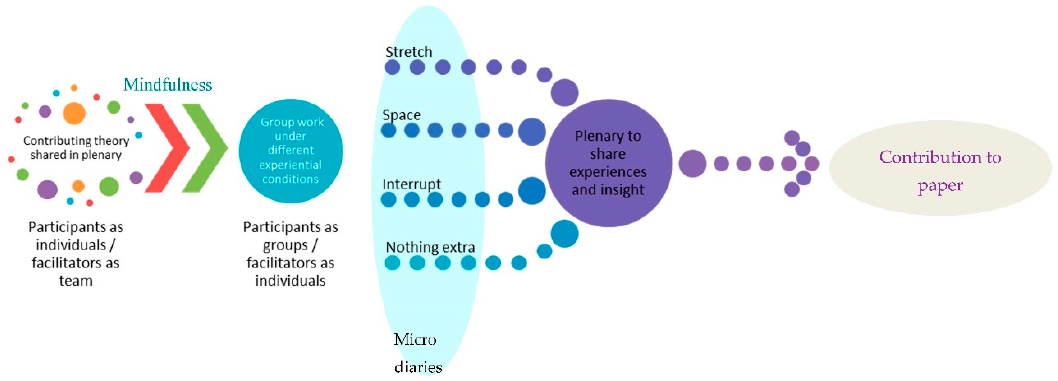
Figure 2. Schematic of Participant Experience at the AoM PDW.